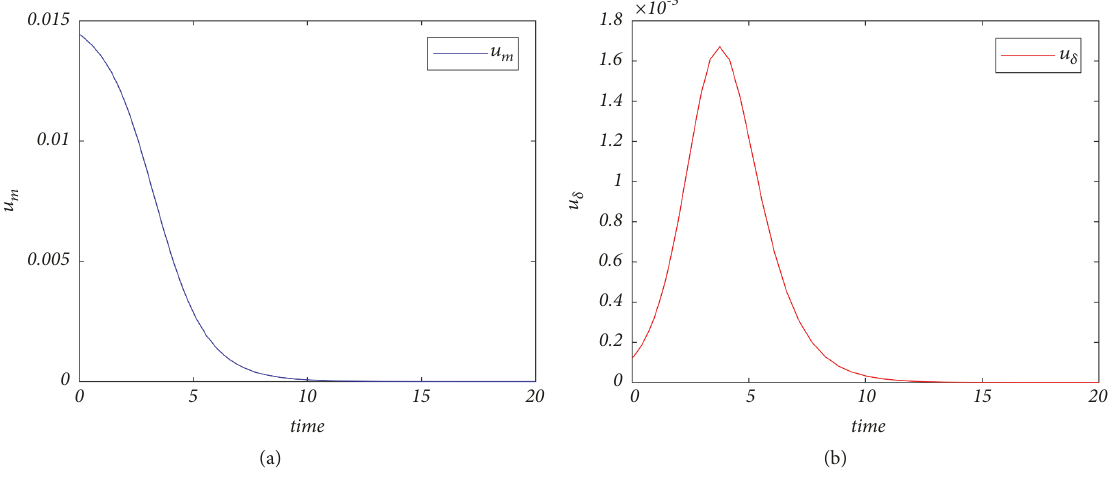
Figure 6: Time evolution of control variables ((a) for 𝑢 𝑚 , (b) for 𝑢 𝛿